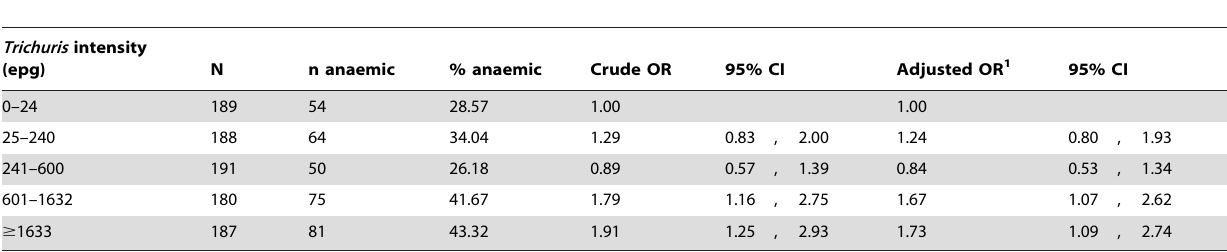
Table 2. Association between Trichuris intensity in the second trimester and anemia risk in the third trimester.